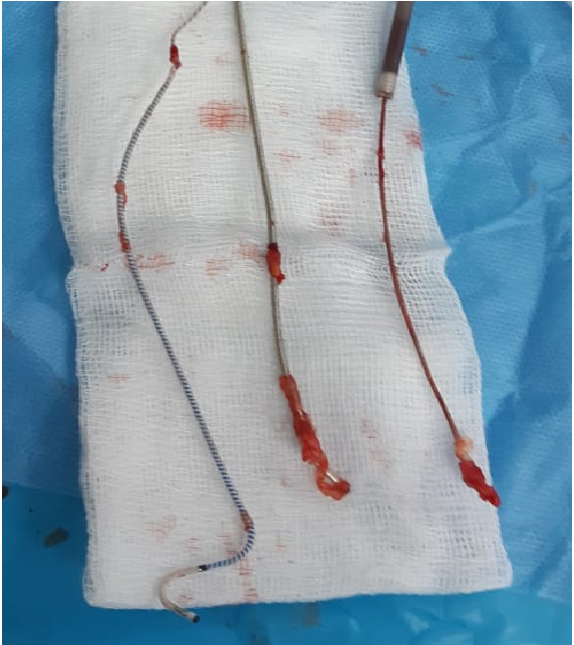
Figure 9. Extracted leads with excessive fibrous tissue on the distal end of RA and RV leads.